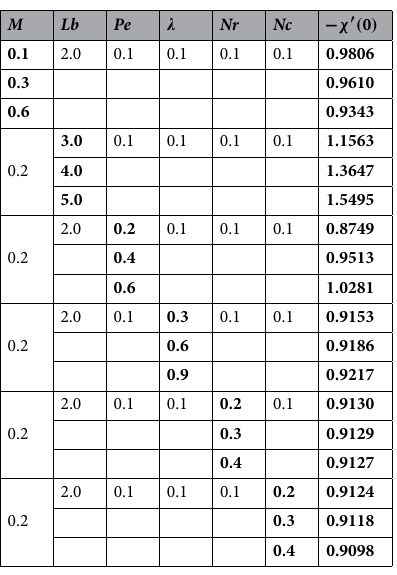
Table 4. Visualizes the significance M, Lb, Pe, ⅄ , Nr, and Nc on local microorganism density number. Significant values are in [bold].